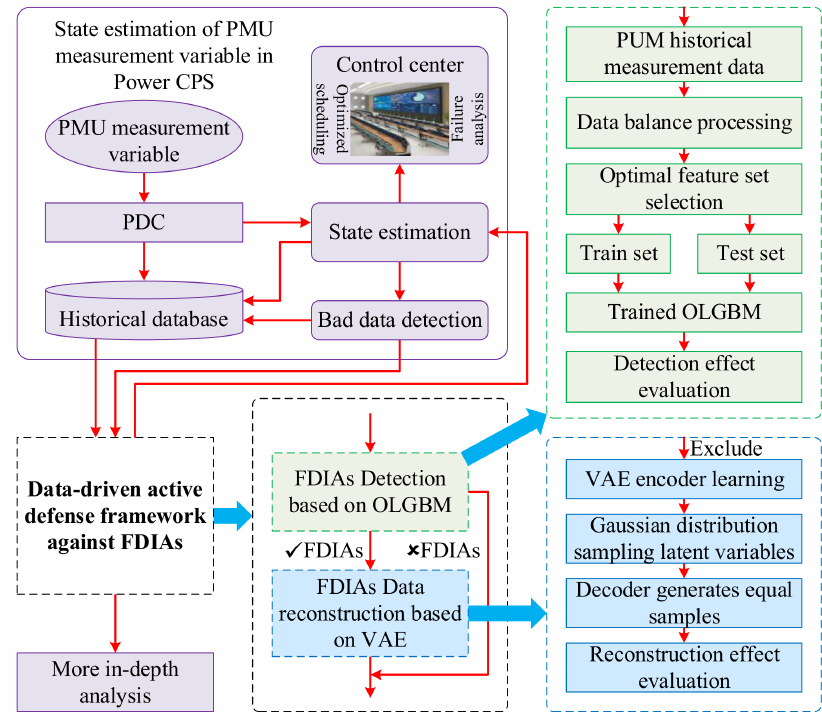
Figure 8. Active defense framework against